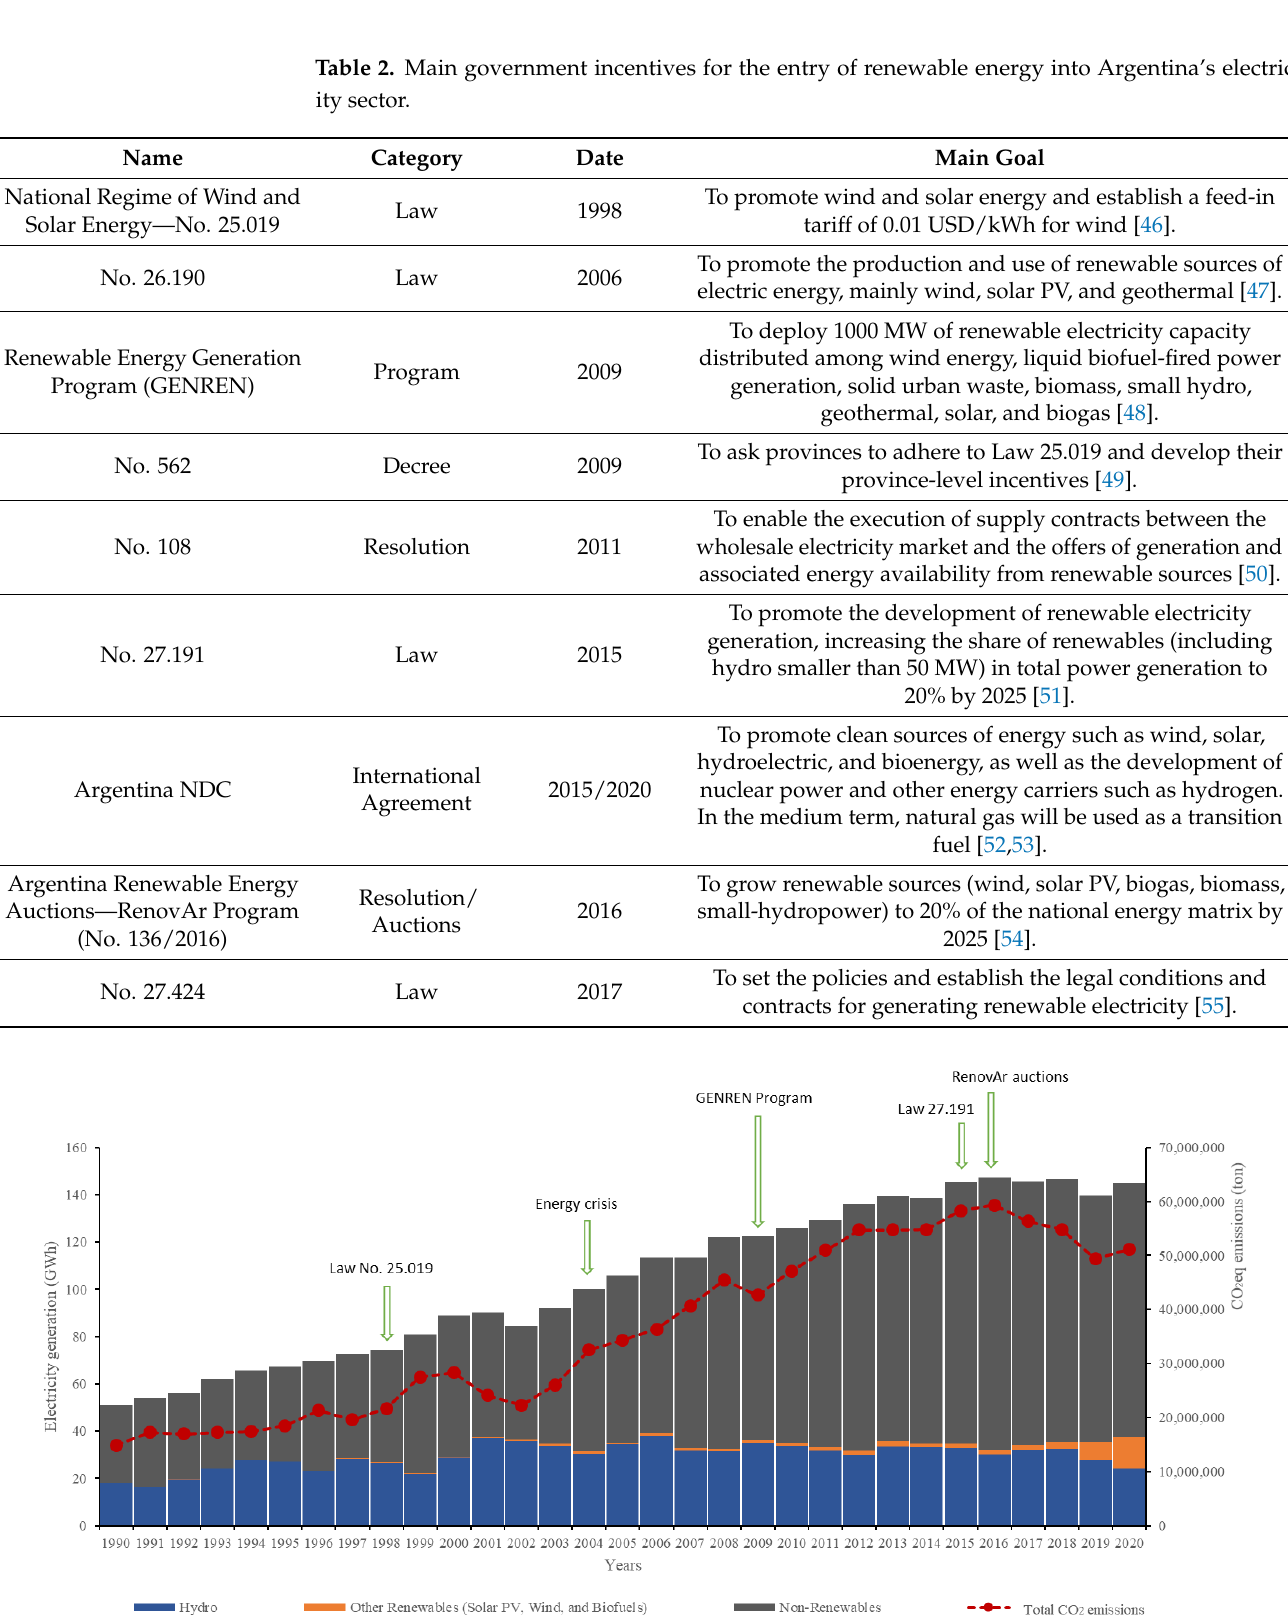
Figure 2. Argentina’s electricity generation from renewable (colored scale bars) and non-renewable (grayscale bars) sources and the total CO 2 eq emissions. Source: Elaborated by the authors based on [38 – 40].